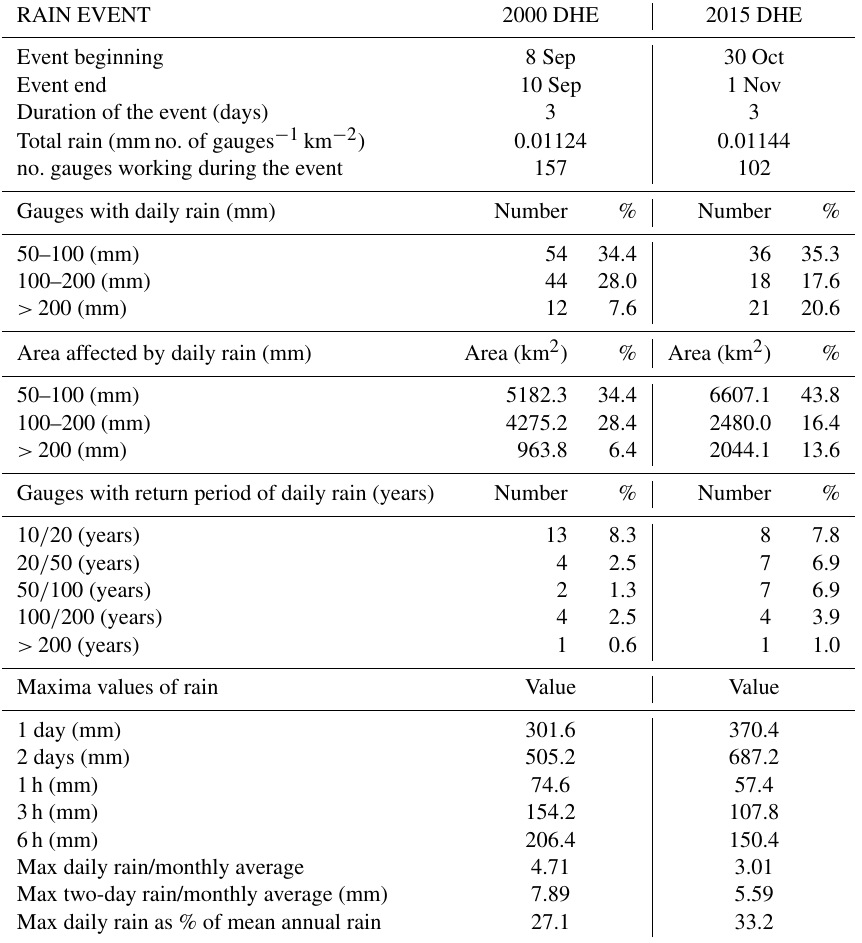
Table 1. Summary of the rain characteristics of the 2000 and 2015 DHE. RAIN